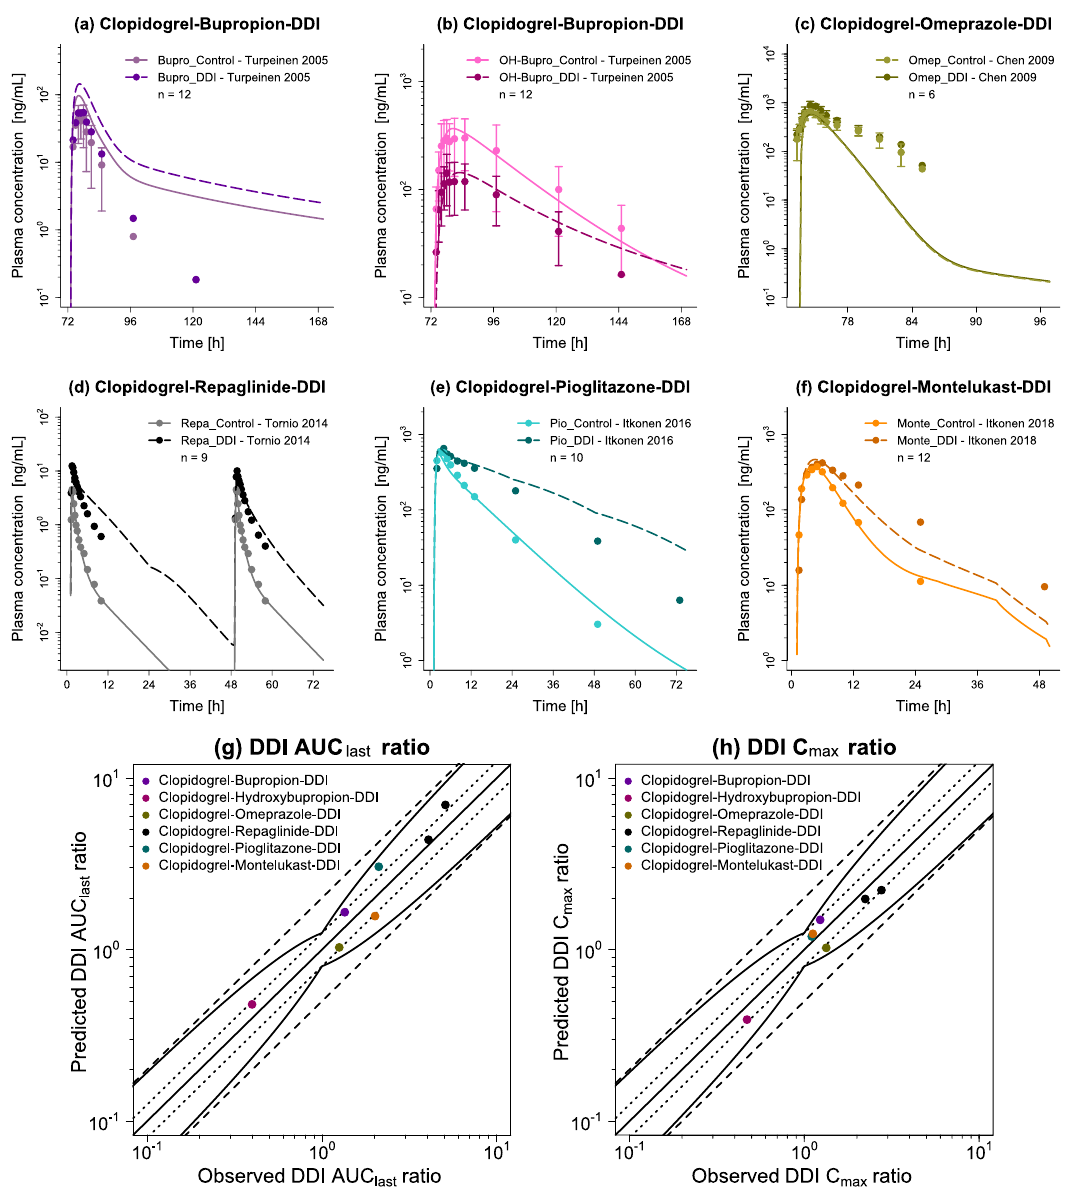
Figure 7. Drug–drug interaction network evaluation with clopidogrel as perpetrator. Presented are predicted plasma concentration-time profiles of the respective victim with (DDI) and without (Control) intake of clopidogrel (( a ) bupropion, ( b ) hydroxybupropion, ( c ) omeprazole, ( d ) repaglinide, ( e ) pioglitazone, ( f ) montelukast), alongside corresponding observed data [31–33,36,83]. Dashed (DDI) and solid (Control) lines represent the model predictions, while corresponding observed data are shown as symbols ( ± standard deviation, if available). Predicted versus observed ( g ) DDI AUC last and ( h ) DDI C max ratios are shown with the solid line representing the line of identity, dotted lines indicating 1.25-fold, and dashed lines 2-fold deviation from the respective observed value, along with the curved lines marking the prediction success limits proposed by Guest et al. [75] (including 20% variability to account for uncertainties in observed ratios). Detailed information on all DDI studies as well as individual DDI AUC last and DDI C max ratios are provided in Tables S10 and S19 of the Supplementary Materials. AUC last : area under the plasma concentration-time curve determined between first and last concentration measurements, bupro: bupropion, C max : maximum